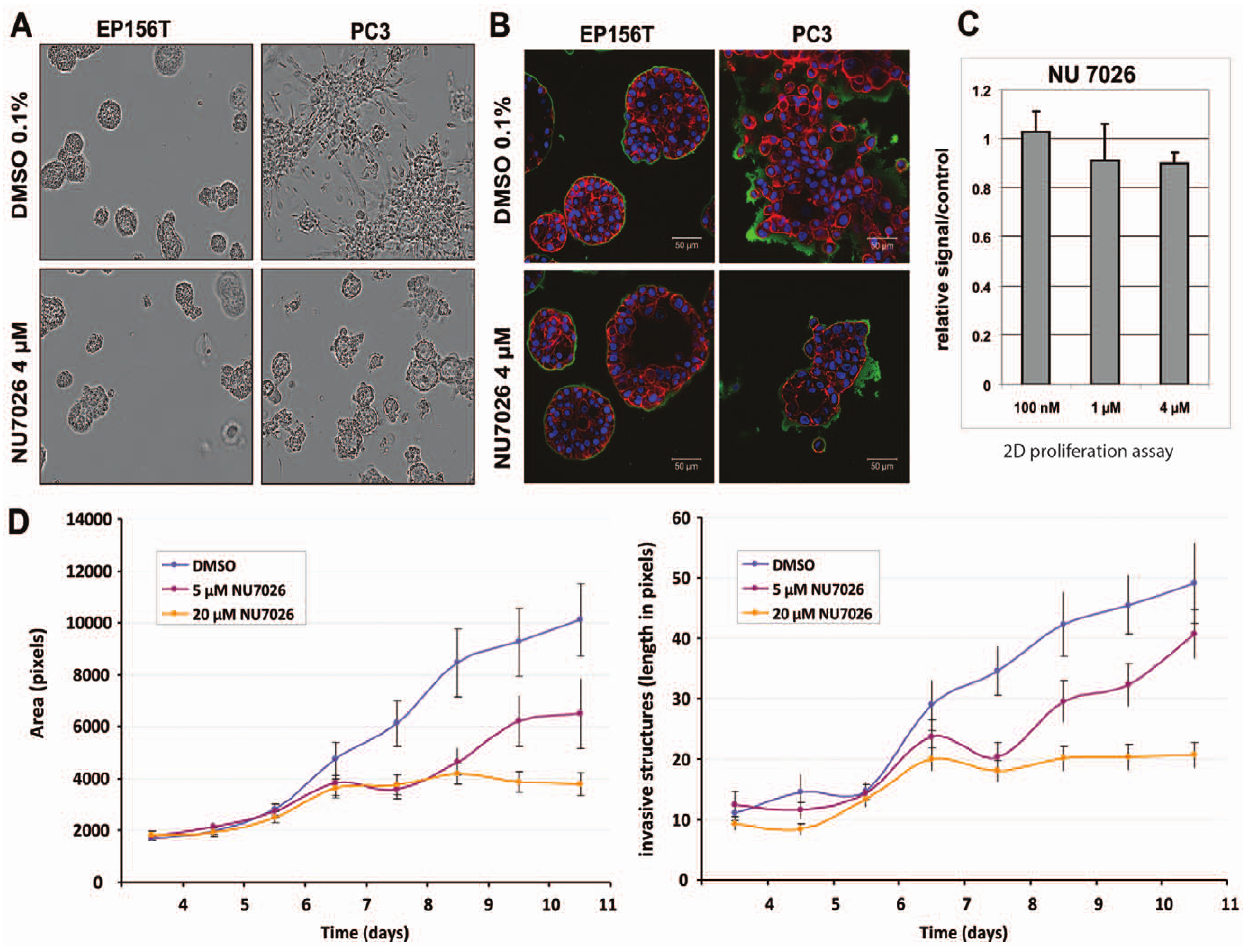
Figure 8. Exemplary response of spheroids from normal (EP156T) and invasive prostate cancer cells (PC-3) to the drug NU7026, a small molecule inhibitor specifically targeting PI3-kinase. A) Live-cell imaging of normal (EP156T) and invasive (PC-3) spheroids, treated with NU7027. B) Immune fluorescence of NU7026-treated EP156T and PC-3 spheroids, using an antibody targeting laminin b 1 (green) and Alexa488- coupled phalloidin (F-actin). DAPI was used for nuclear staining. Drug exposure blocks the transformation of PC-3 spheroids into the stellate phenotype, but does not affect formation of normal spheroids. Vehicle-only (0.1% DMSO) served as a control. C) Lack of response of PC-3 cells to NU7026 (72 h) in monolayer culture (CTG, Cell Titer Glo assay). D) Quantitation of size (area, total # of pixels) and # of appendages (invasive structures, median length in pixels) in treated vs. untreated PC-3 spheroids. Bars represent the standard error.